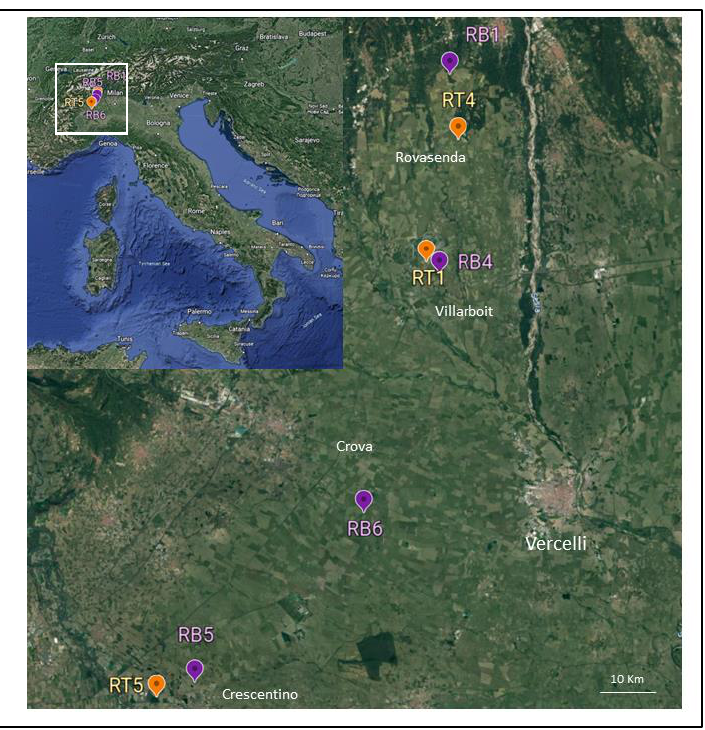
Figure 1. Localization of crops involved in the research project. Table 1. Identification code, the municipality, and type of agronomic management (RT = conven- tional; RB = organic) of the seven rice paddies considered in the research.